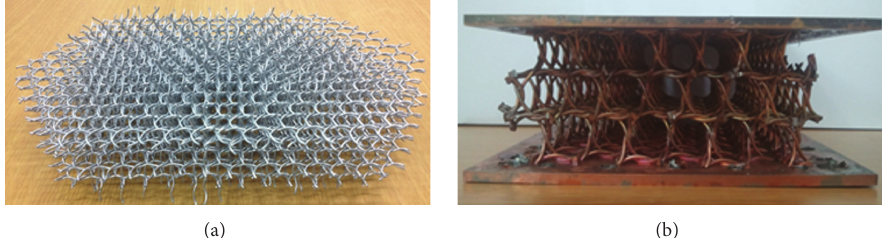
Figure 1: Configuration of the Kagome truss: (a) wire-woven bulk Kagome fabricated by a three-dimensional assembly of wires and (b) a wire-woven bulk Kagome damper